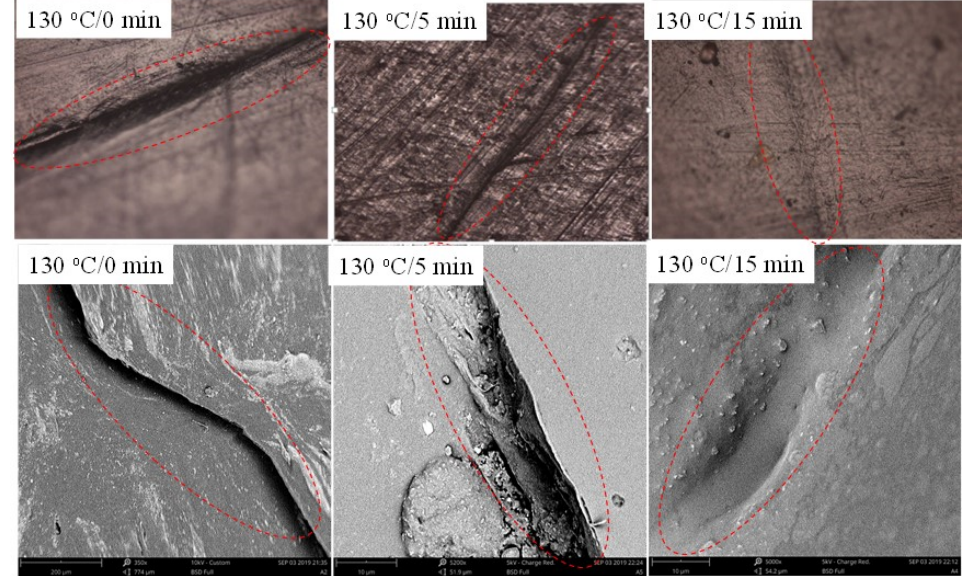
Figure 12. Optical and SEM images of scratch sample healed at 130 ◦ C for di ff erent time using electricity.